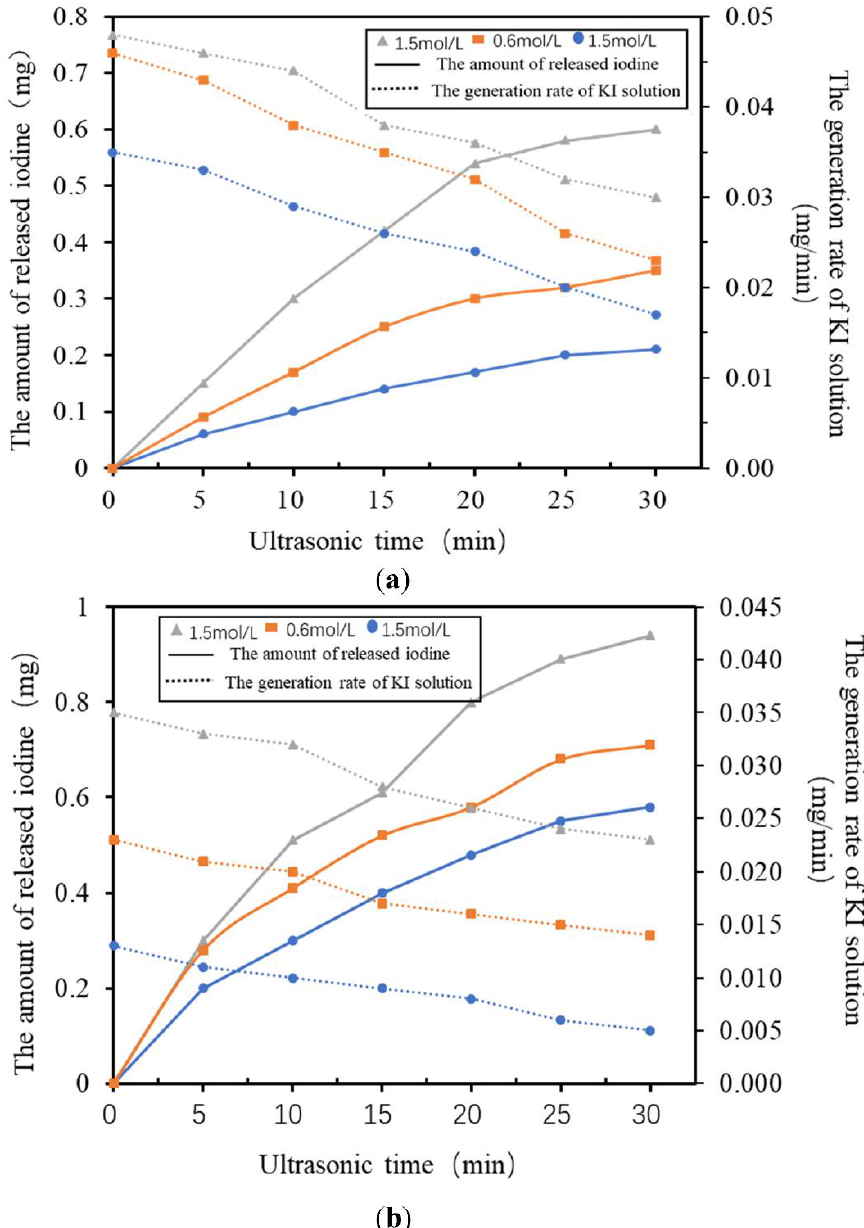
Figure 10. Relationship between the yield of essential iodine, the generation rate and the time of ultrasonic irradiation in KI solutions with different initial concentrations: ( a ) 2 MHz and ( b ) 3